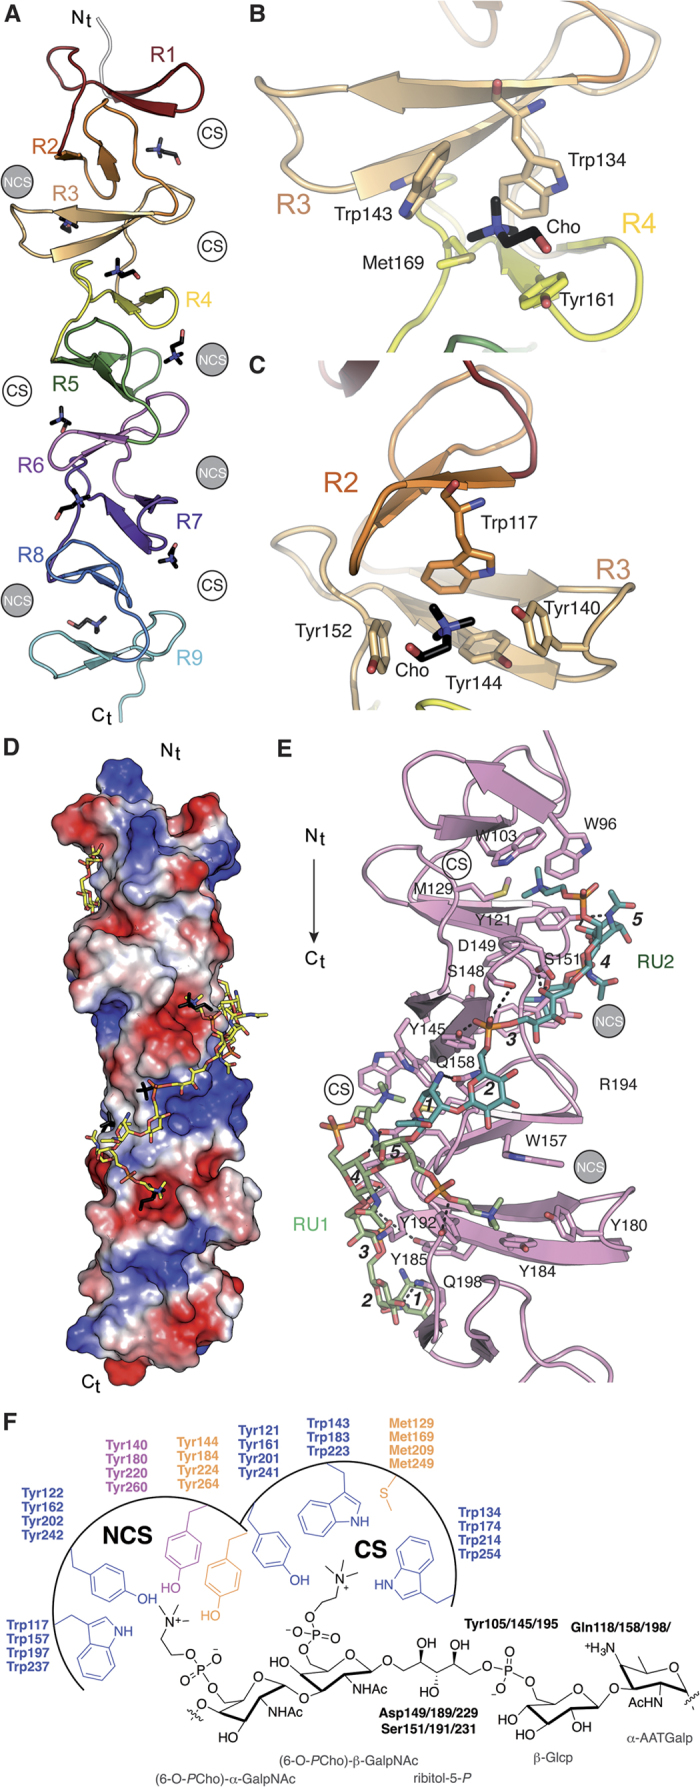
Crystal structure of the CBM and teichoic acid recognition of CbpL.(A) Ribbon representation of the overall fold of the CBM. Each choline-binding repeat is colored differently and labeled (R1–R9). Choline moieties attached to the choline-binding sites are represented as capped sticks with C atoms in black. Canonical (CS) and non-canonical (NCS) sites are labeled. (B) Molecular architecture of the canonical choline-binding site with critical residues represented as capped sticks and labeled. (C) Molecular architecture of the non-canonical choline-binding site with critical residues represented as capped sticks and labeled. (D) Electrostatic-potential surface of the crystal structure of CbpLCBM:choline complex with the docked model of three TA units (yellow sticks for C atoms) superimposed. Choline moieties and sulphate molecules from the CbpLCBM:choline complex are depicted as black sticks for comparison purposes. (E) Detailed view of the interactions between two docked TA repeating units (RU1 and RU2, light green sticks and dark green sticks respectively) and the CbpLCBM (pink ribbon). Different sugars composing RU in TA are labeled (1: α-AATGalp, 2: β-Glcp, 3: ribitol-5-P, 4: (6-O-PCho)-β-GalpNAc and 5: (6-O-PCho)-α-GalpNAc). Residues involved in TA stabilization are depicted as capped sticks. Canonical sites (CS) and non-canonical sites (NCS) are labeled and polar interactions represented as dotted lines. (F) Scheme of the TA recognition by CS and NCS in CbpL. Residues involved in TA binding are conserved along the CbpLCBM (labeled).